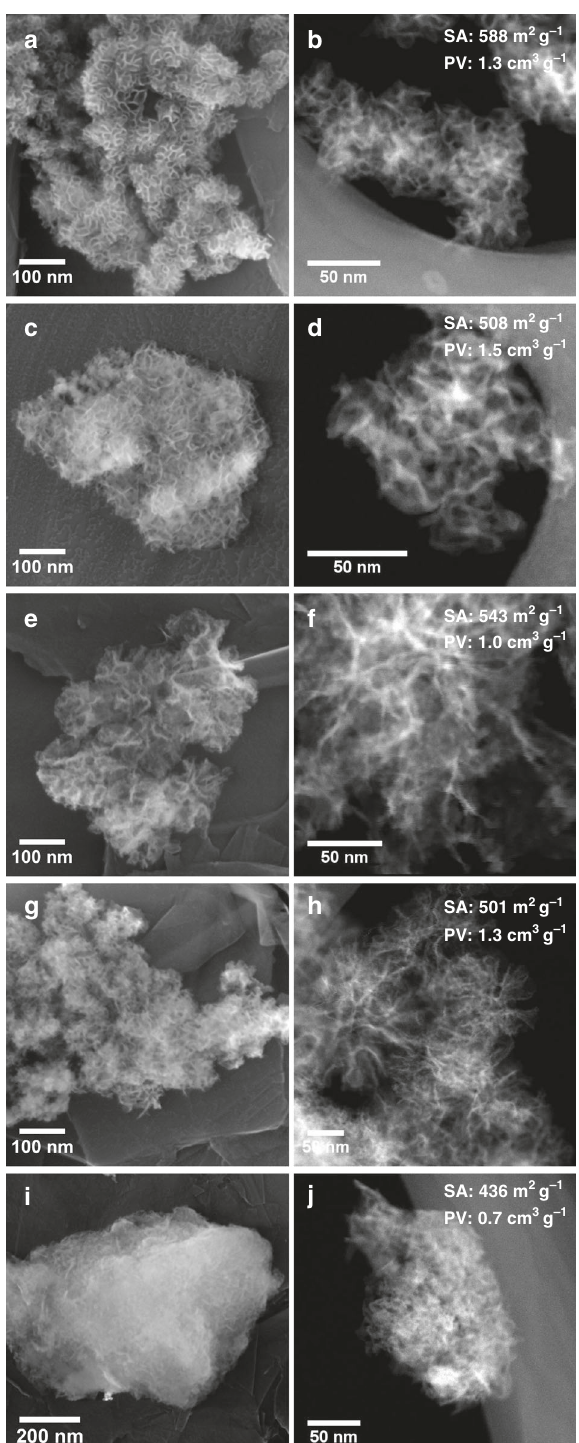
Fig. 1 Electron microscope imaging. Scanning electron microscope ( fi rst column), HAADF transmission electron microscope images (second column) of the synthesized AAS, and BET surface area (SA) and BJH adsorption pore volume (PV) of a , b AC * -1.9, c , d AC-1.9, e , f AC-9, g , h AC-1.3, and i , j